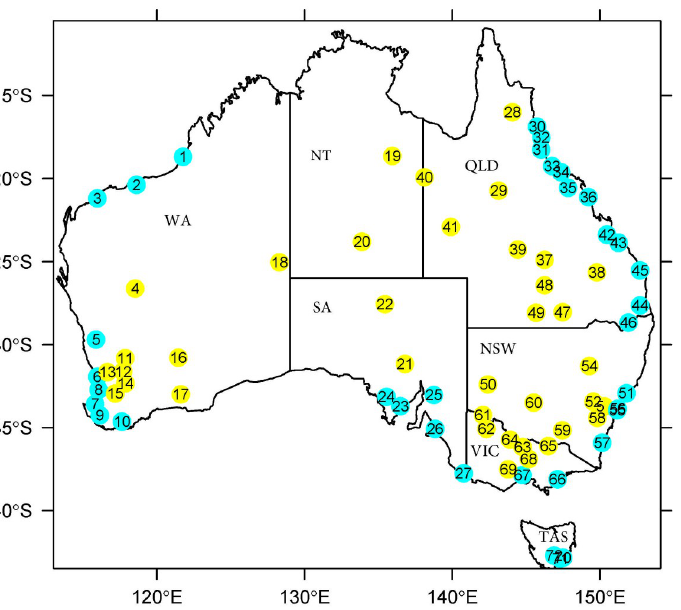
Fig 1. The distribution of selected stations with qualifying data. Blue dots are for (near) coastal stations and yellow dots are for inland stations.